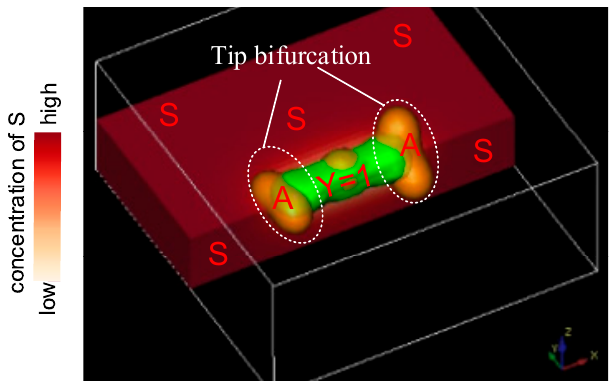
Figure 3. Schematic illustration of the profile of activator concentration along the direction transverse to stalk elongation. The tip bifurcation direction deviates from the primary stalk extension direction. In order to study the distribution and relative time-dependent changes of activator A and inhibitor H in the transverse direction perpendicular to that of stalk extension, typical bifurcation (tip-splitting) was simulated. Here, we selected the simulation results after 2800, 3150, and 3600 steps respectively, and drew the corresponding 3D graphics of multicellular morphologies for analysis. The specific numerical values and variation tendencies of activator A and inhibitor H along a certain spatial coordinate axis k are shown in Figure 4.